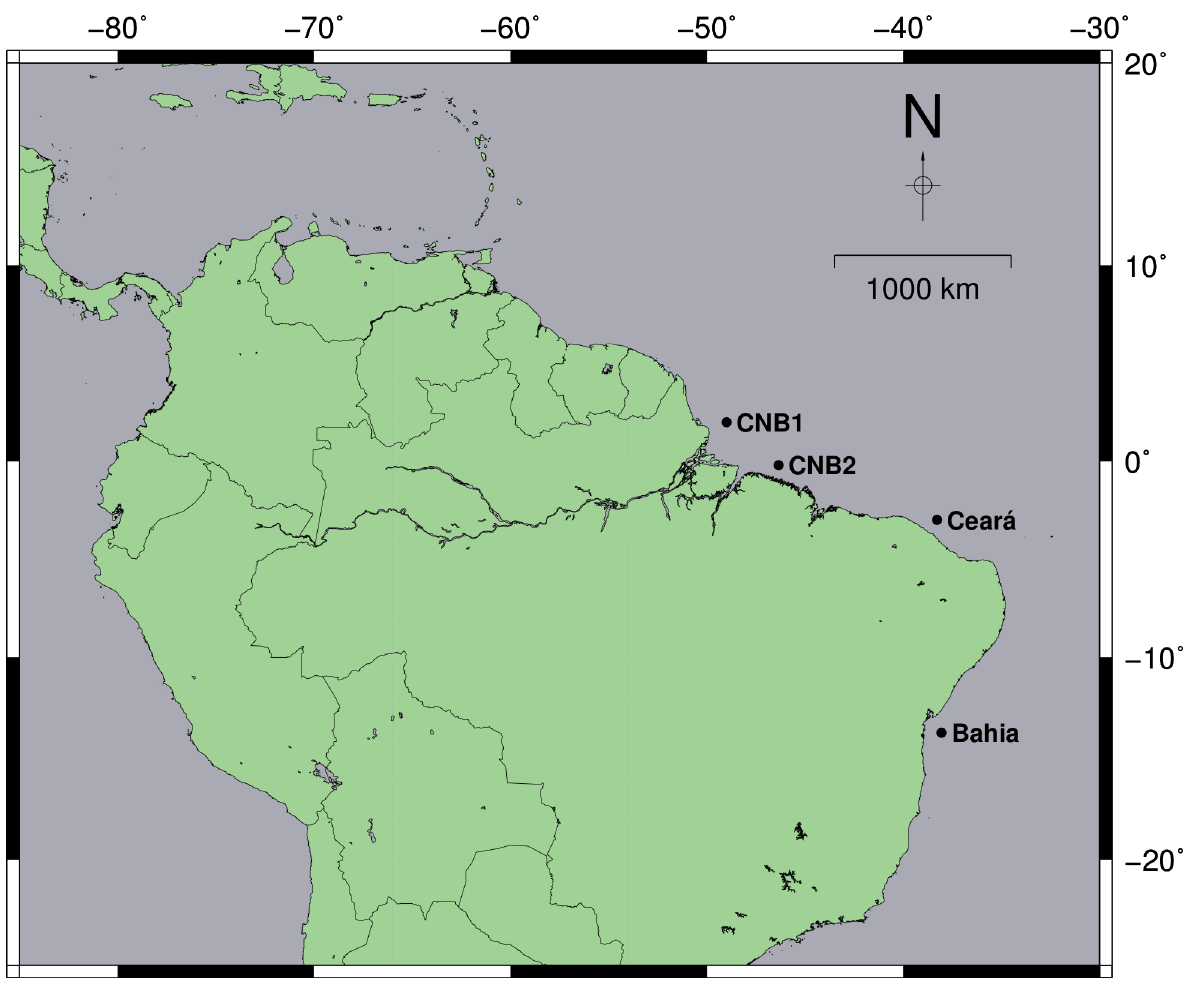
Fig 1. Map of the spatial distribution of L . purpureus specimen collection points used in this study. CNB1- North Coast of Brazil 1 (Pará and Amapá). CNB2- North Coast of Brazil 2 (Maranh ã o). Map created in GMT 5.1.2 [14].